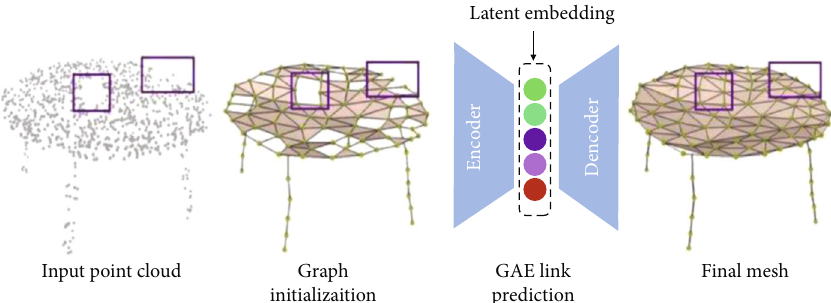
Figure 3: “ Unsupervised-link-prediction-using-GAE-The-learned-latent-embeddings-are-used-to-predict. ”